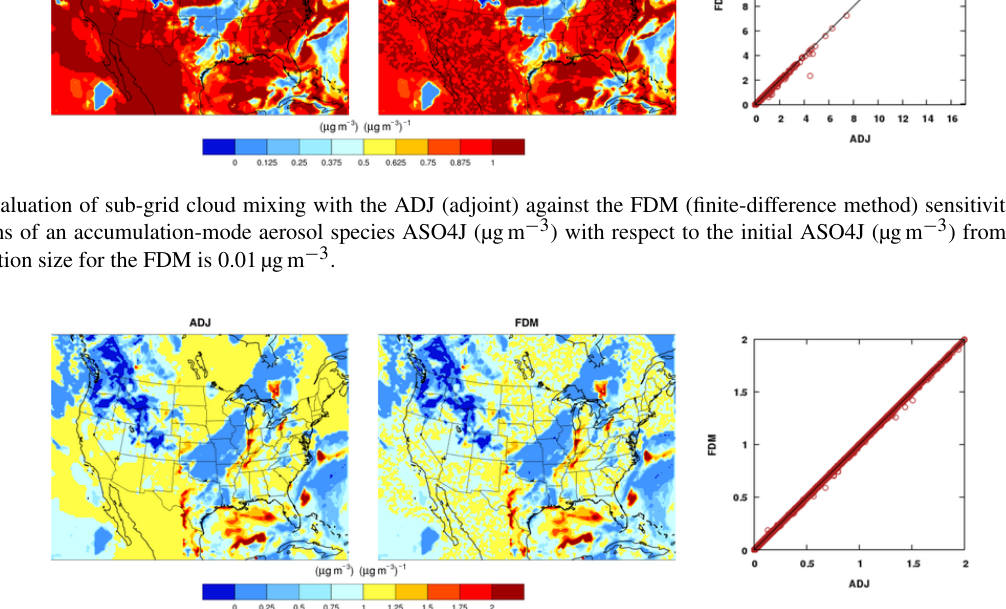
Figure 6. Evaluation of cloud dynamics and aqueous chemistry with the ADJ (adjoint) against the FDM (finite-difference method) sensitiv- ities of the final concentrations of an accumulation-mode aerosol species ASO4J (µgm − 3 ) with respect to the initial ASO4J (µgm − 3 ) from a 1d test run. The perturbation size for the FDM is 0.01µgm − 3